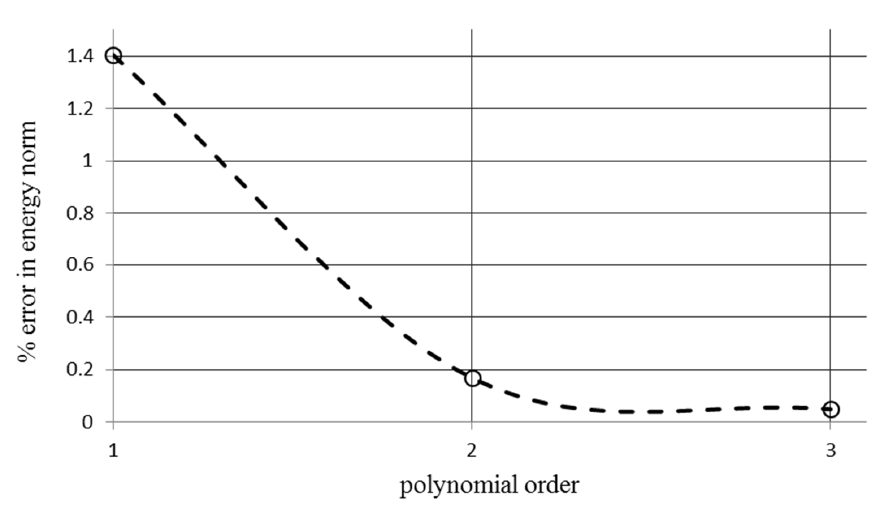
Figure 7. P-method mesh refinement shows reduction of the error of the norm energy by increasing the order of the polynomial function.